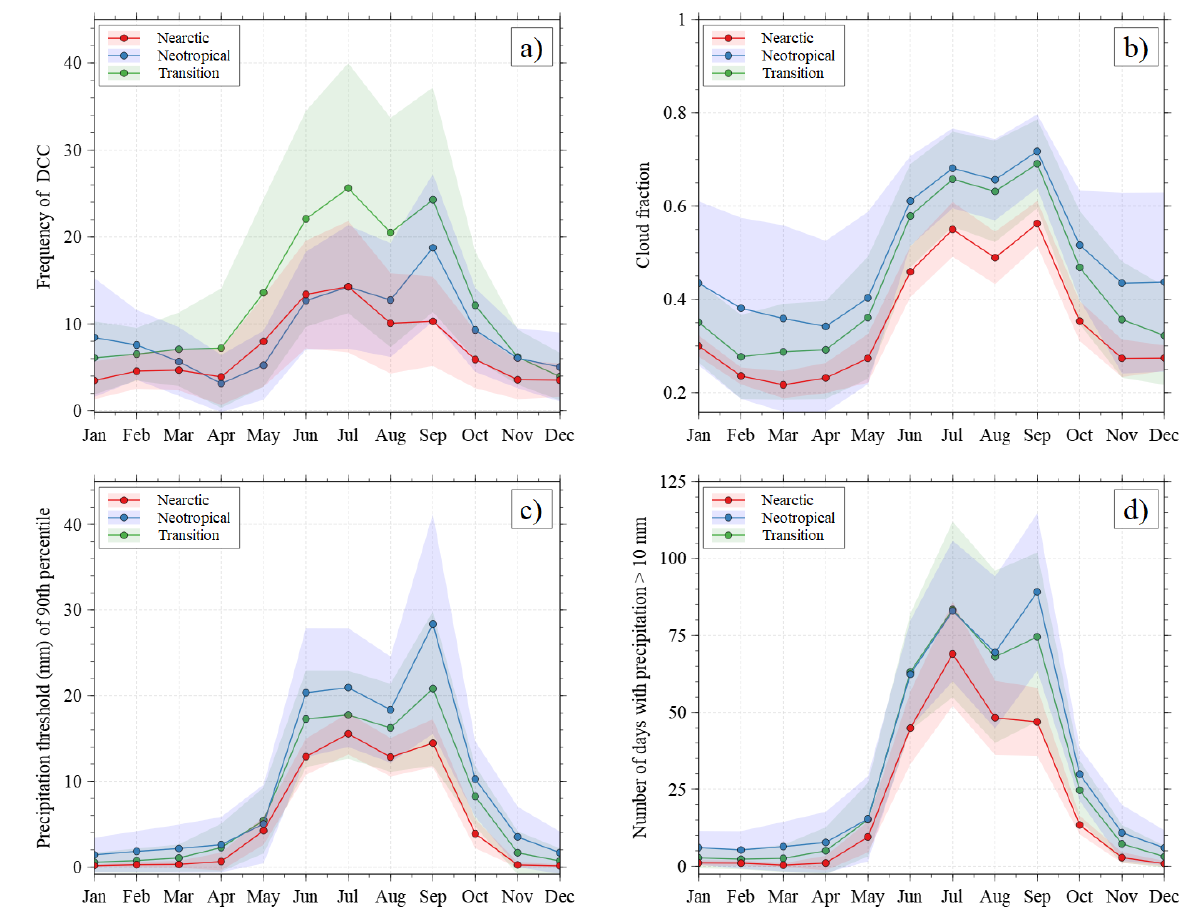
Figure 8. Monthly means (lines) and one standard deviation (shaded areas) of ( a ) observed deep convective cloud (DCC) frequency, ( b ) cloud fraction (CF), ( c ) precipitation threshold values and ( d ) number of days with precipitation exceeding 10 mm per Nearctic, Neotropical, and Transition